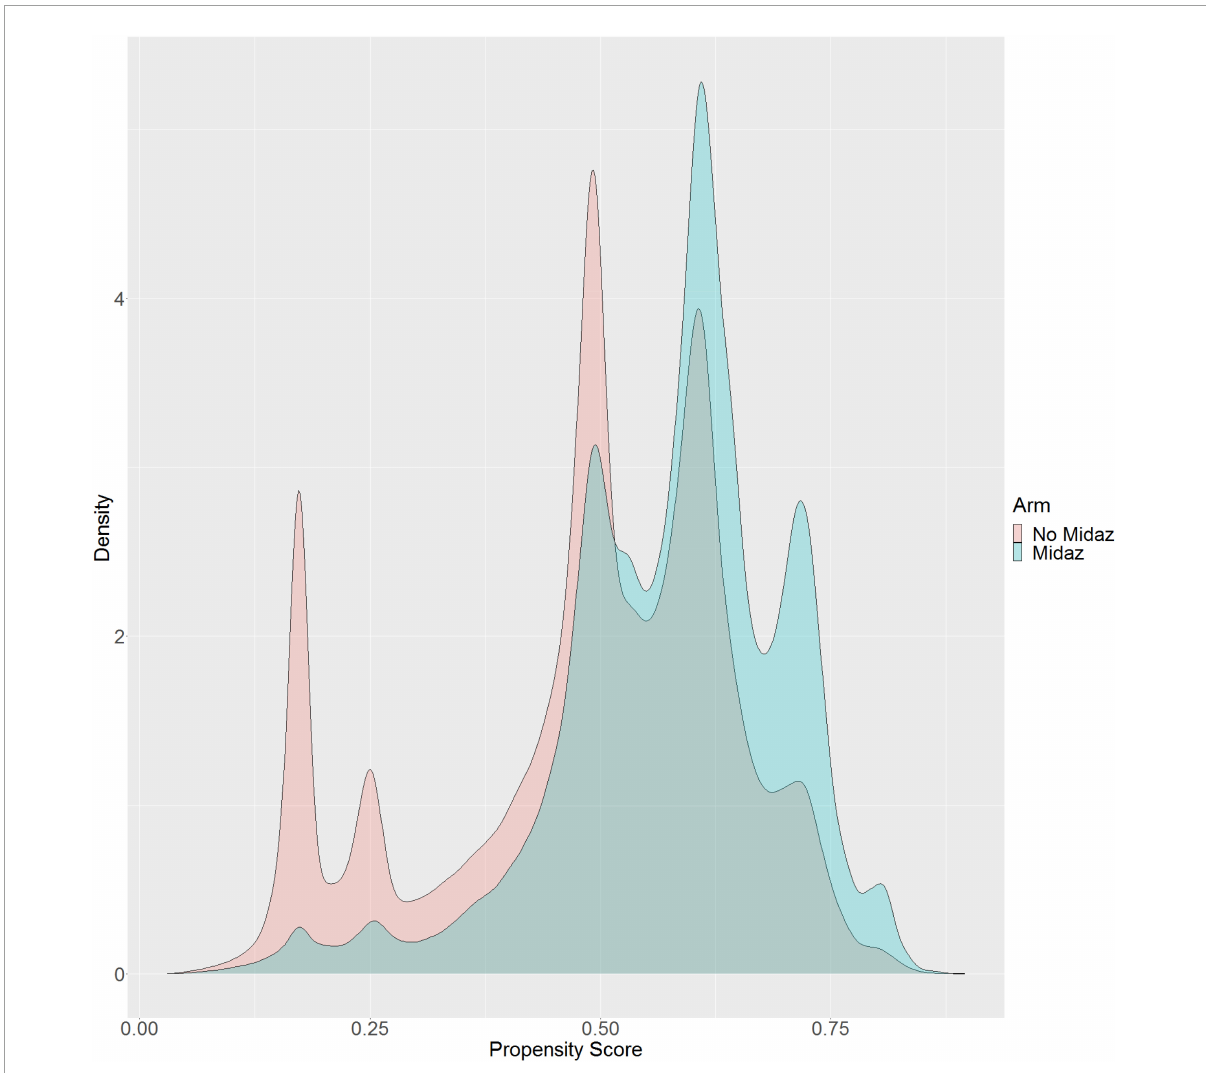
FIGURE3 Distribution of the propensity score stratified by whether subjects received perioperative